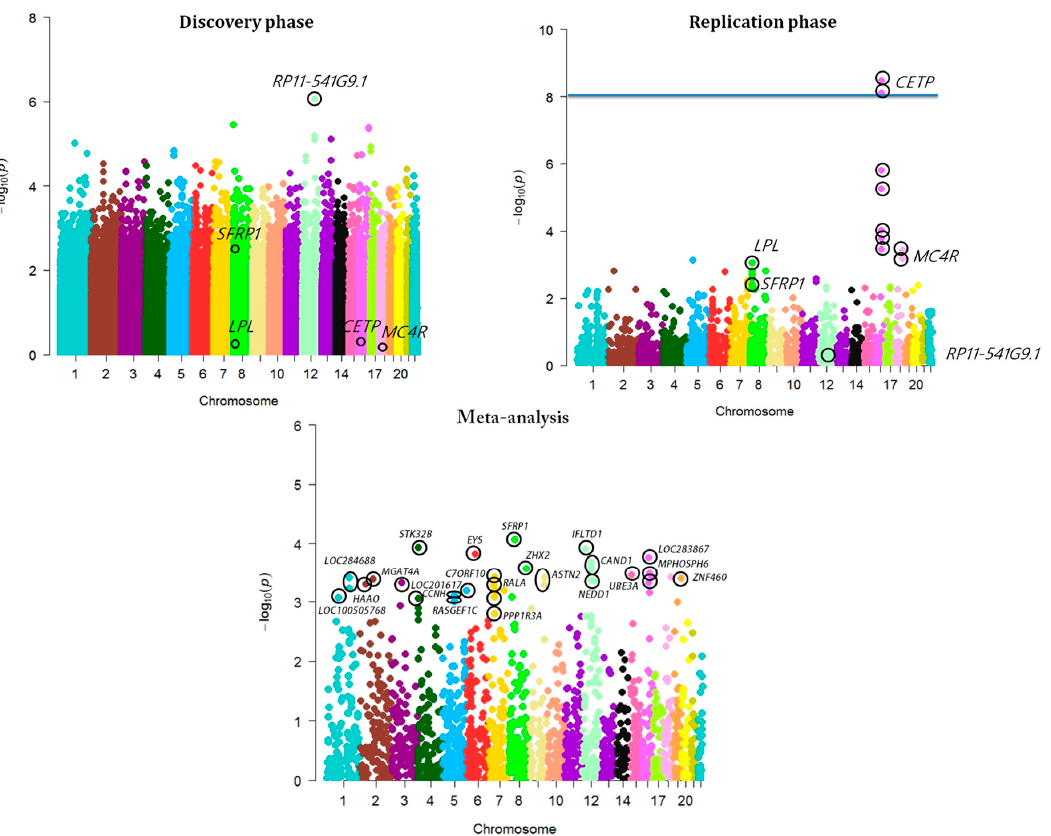
Figure 1. Manhattan plot of association p-values for metabolic syndrome (MetS) in discovery phase, replication phase, and meta-analysis. The − log10 p -values of genotyped single nucleotide polymorphisms (SNPs) calculated from association analysis have been presented with respect to SNP positions across autosomes (National Center for Biotechnology Information Build 37).